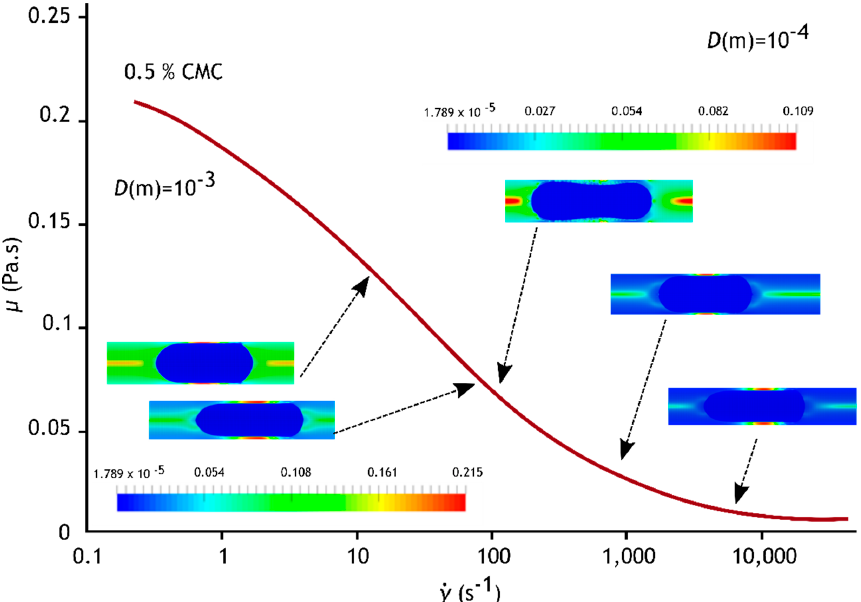
Figure 4. Viscosity fields along the characteristic viscosity curve of a 0.5% CMC solution obtained for microchannels with a 100 μ m and 1000 μ m diameter. The viscosity curve was calculated using Equation